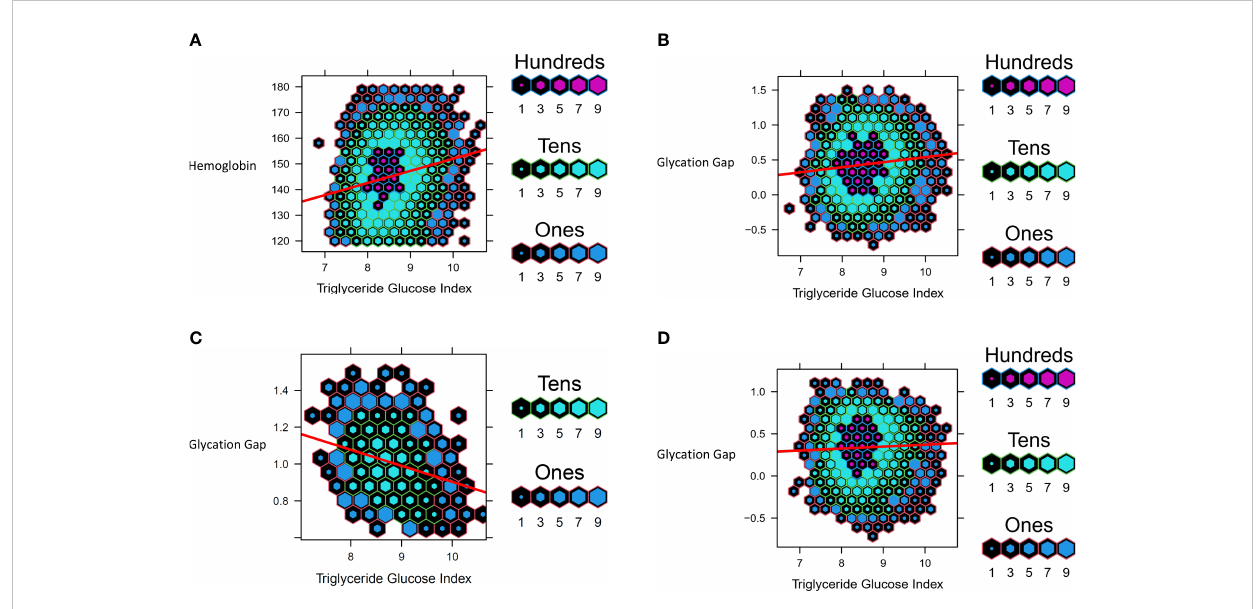
FIGURE 4 Data from UHN cohort. Hexbin plots represent number of study participants with the observed and calculated values, where the color and size of each individual hexagon correlates to the number of participants with the corresponding values. The red line represents the regression line for each cohort. (A) Association between Triglyceride Glucose Index and Hemoglobin (B) Association between Triglyceride Glucose Index and Glycation Gap in all participants (C) Association between Triglyceride Glucose Index and Glycation Gap in with pre-T2D (D) Association between Triglyceride Glucose Index and Glycation Gap in those with